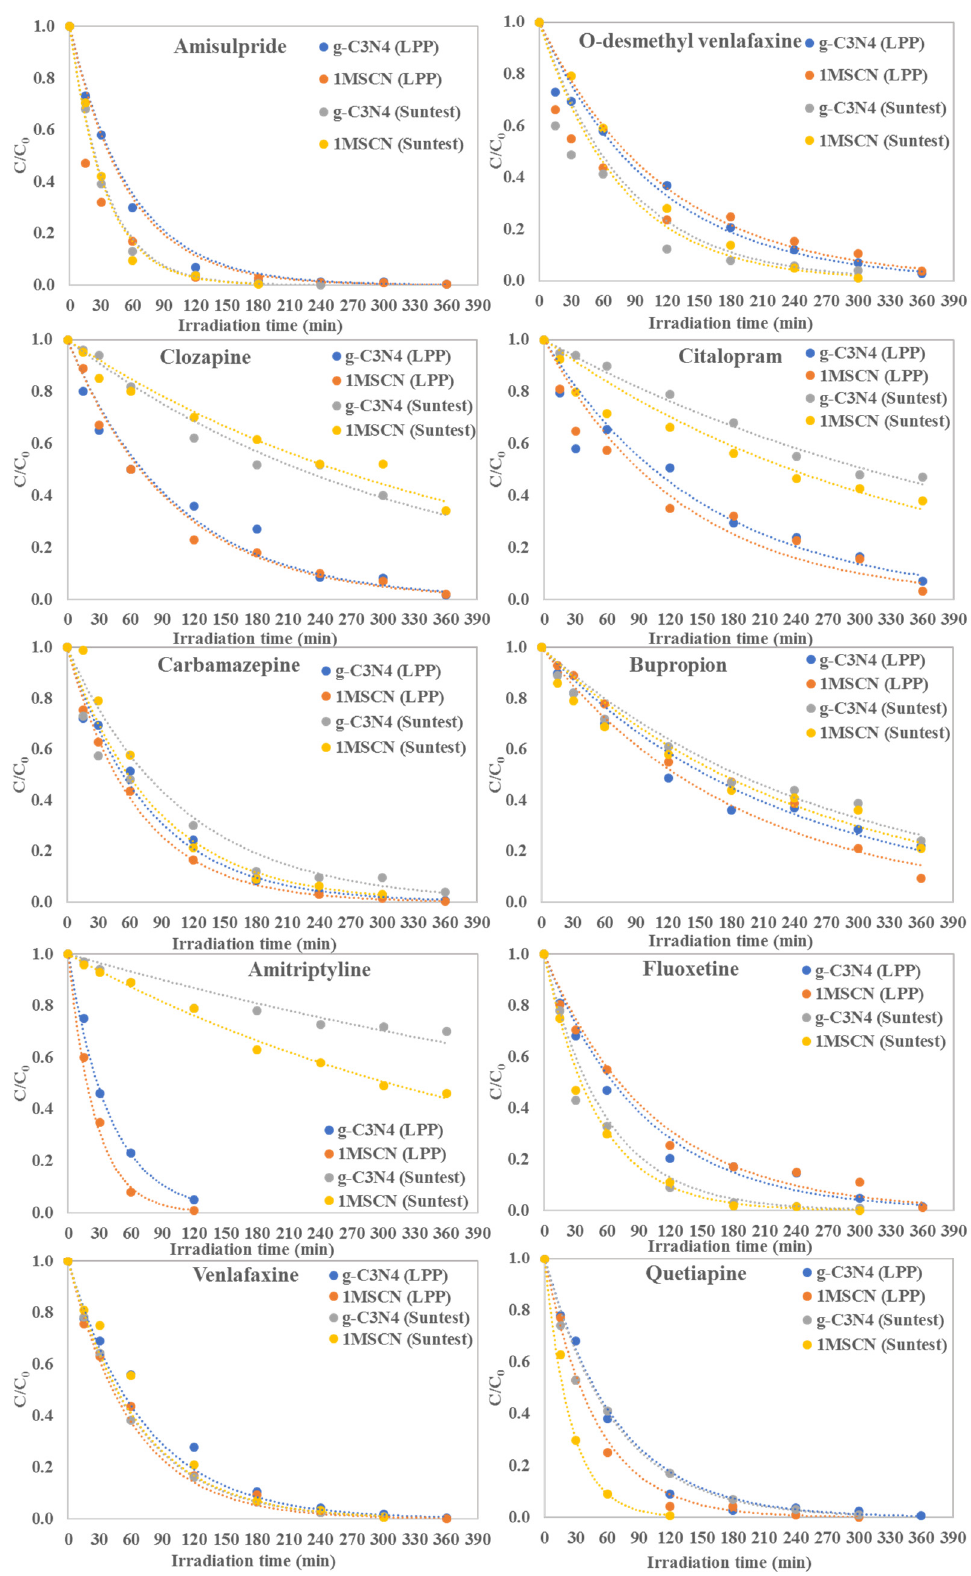
Figure 1. Photocatalytic degradation of psychiatric drugs using g-C 3 N 4 and 1MoS 2 /g-C 3 N 4 catalysts in lab-scale pilot plant (LPP) and in solar simulator (Suntest) as a function of irradiation time.